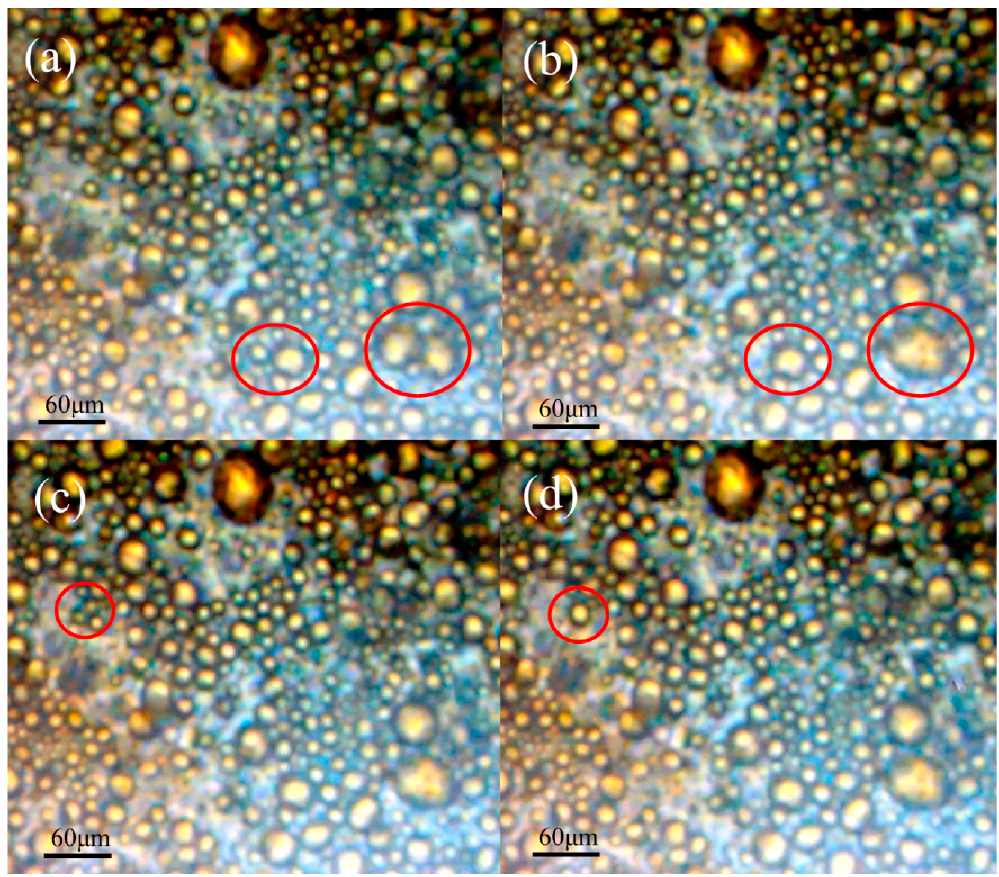
Figure 4. Video screenshots of kerosene/water emulsions flowing in the TAPM. The droplets are marked with red circle. ( a ) before the two droplets coalesced; ( b ) after the two droplets coalesced; ( c ) Before the three droplets coalesced; and ( d ) after the three droplets coalesced.